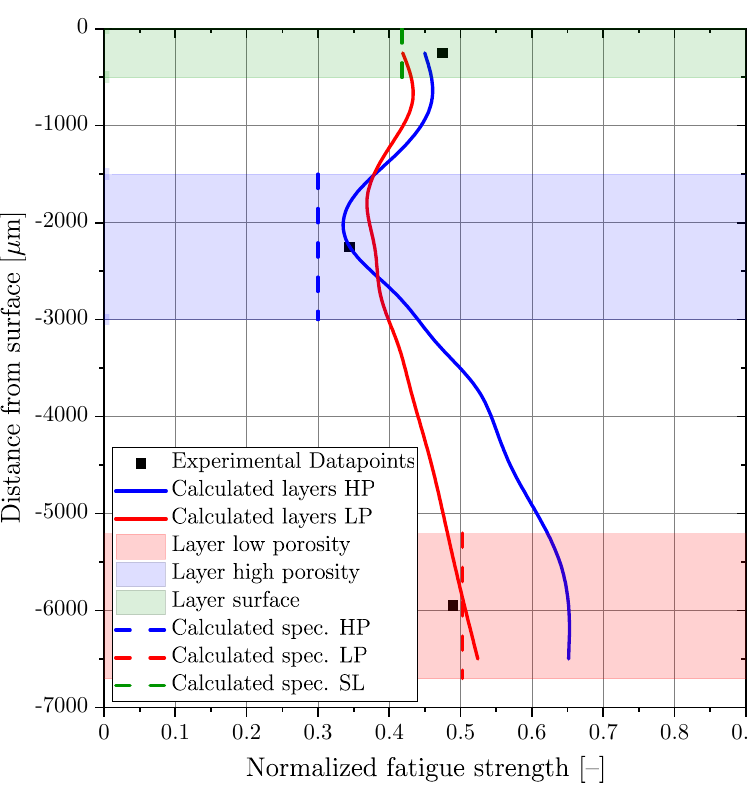
Figure 17. Calculated course of the fatigue strength over the cross section of the thick-walled cast specimen. Table 8. Comparison of the normalized fatigue strength based on the model and the experiment.